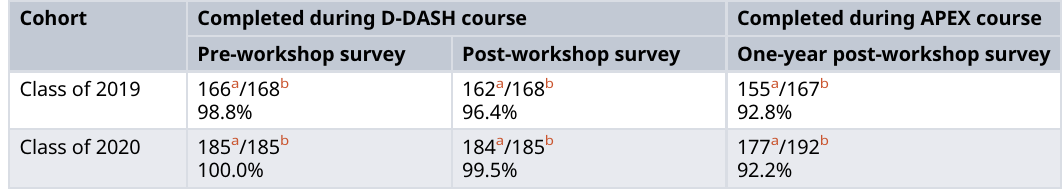
Table 1. Response rate for each data-collection period, by cohort.